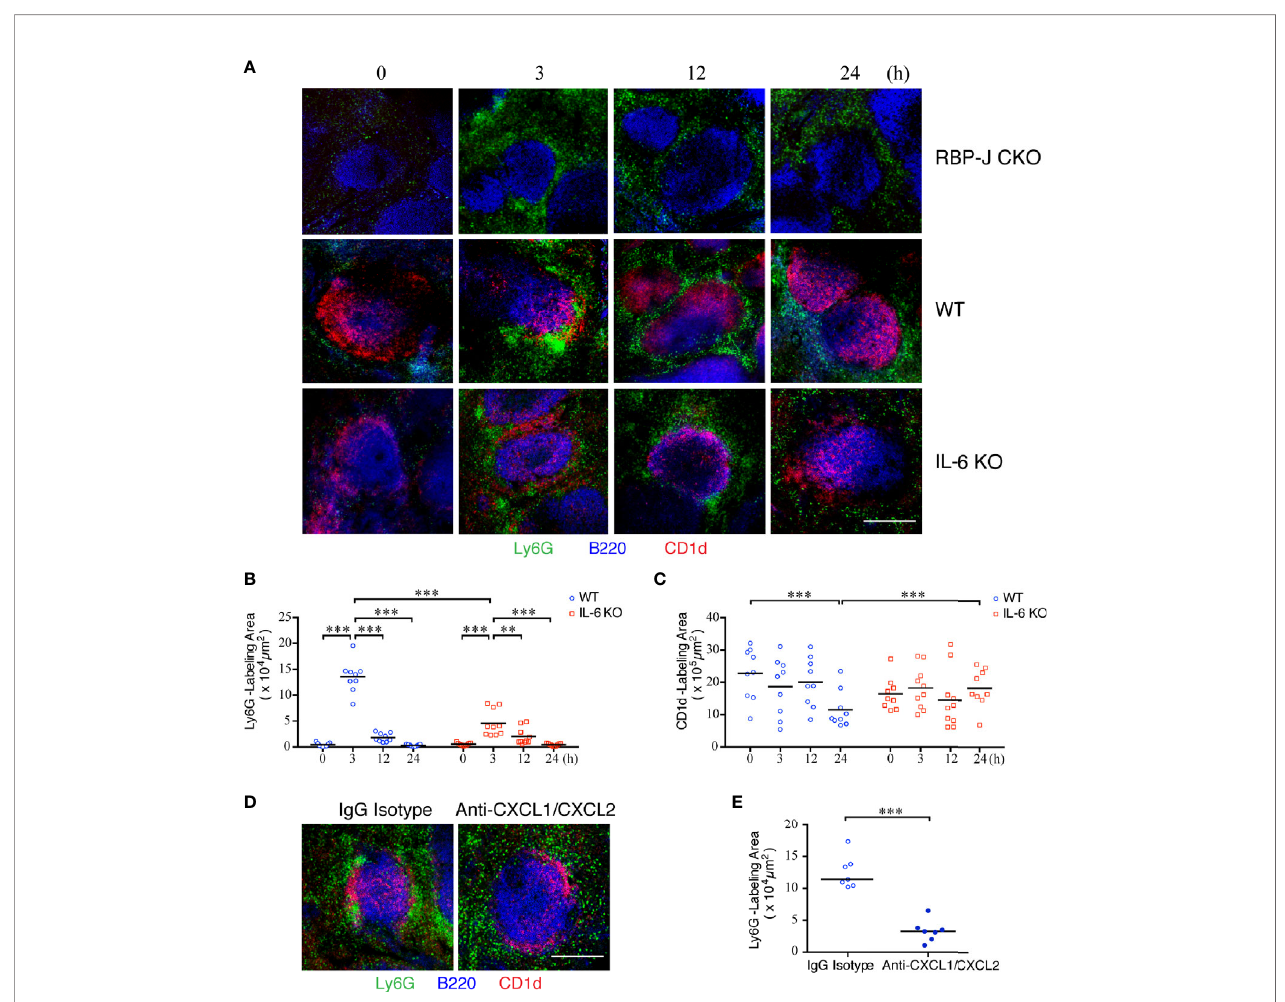
FIGURE 4 | Kinetics of neutrophil swarming and regression in the MZ zone after S. aureus infection. (A) Confocal images of immuno fl uorescent staining of thick spleen sections showing the distribution of MZ B cells (red) and neutrophils (green) at 0, 3, 12, or 24 h after systemic S. aureus (2.5 × 10 6 CFU) infection in RBP-J CKO, WT, or IL-6 KO mice. Scale bar = 200 µm. (B, C) MetaMorph software was used to calculate the area fl uorescently labeled area by Ly6G per CD1d positive area (B) or CD1d (C) inside the white pulp of WT or IL-6 KO mice from the confocal microscopy images in (A) . (D) Confocal images of immuno fl uorescence staining of spleen sections at 3 h after systemic S. aureus (2.5×10 6 CFU) infection showing the numbers of neutrophils (green) in WT mice intravenously injected with anti- CXCL1/CXCL2 or IgG control antibodies one h prior to infection. Scale bar = 200 µm. (E) MetaMorph software was used to calculate the Ly6G fl uorescently labeled area of each CD1d-positive area in the white pulp of WT mice from the confocal microscopy images in (D) . Results were analyzed by performing an unpaired t -test. Data are presented as the mean ± SEM (n = 9 – 10). ** p < 0.01, and *** p <